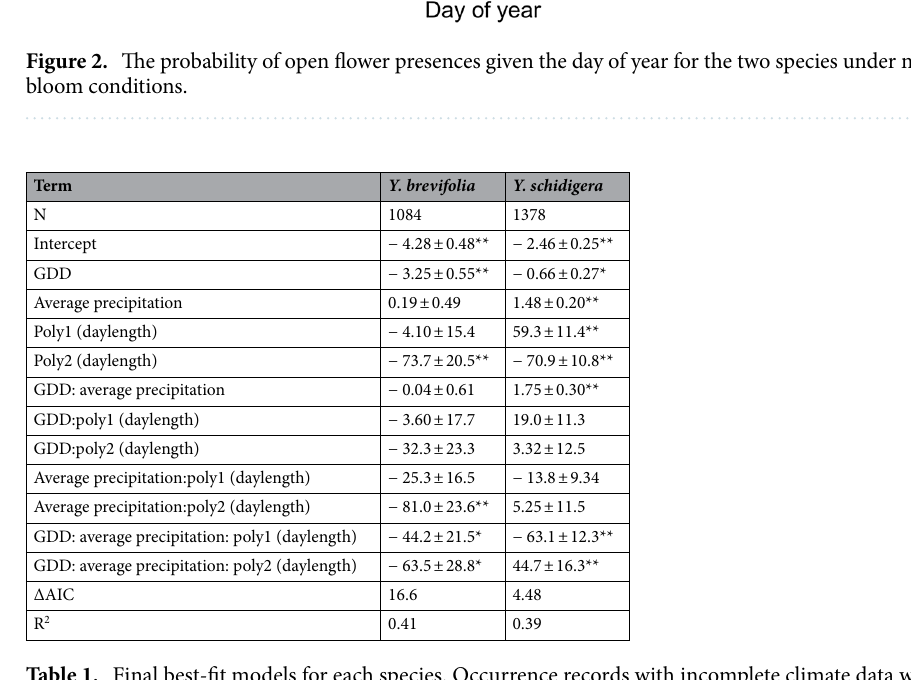
(Table 2). For both species, we found higher commission (false positive) error rates than omission (false nega- tive) error rates. The LPT threshold generated the highest commission error rates and the MaxKappa and LPT 5% thresholds were roughly equivalent in their commission error rates for the anomalous bloom season. We found generally low omission rates across all thresholds. Discussion